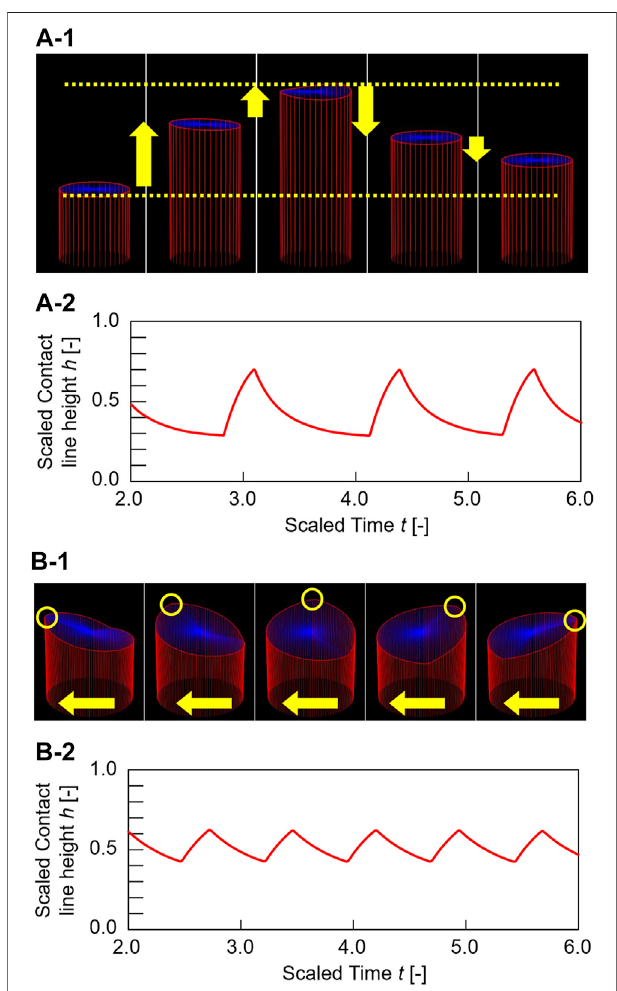
FIGURE 5 | Calculation results. Three-dimensional graphs and time course of contact line height change Δ h of the oil/water contact line motions for (A) L (cid:1) 0.4 and (B) L (cid:1) 1.5. The contact lines of (A) and (B) exhibit up-and- down motionand traveling-wavemotion, respectively. Bluetopsurfaces in the three-dimensional graphs represent oil/water interfaces. The curved surfaces were drawn by connecting between the oil/water interfacial height at center h c ( t ) and the contact line height at arbitrary circumferential displacement. h c ( t ) was estimated by calculating the average of the contact line height at each time < h ( t ) > (h c (t) (cid:1) (cid:7) 0L h(t,x)dx/L).